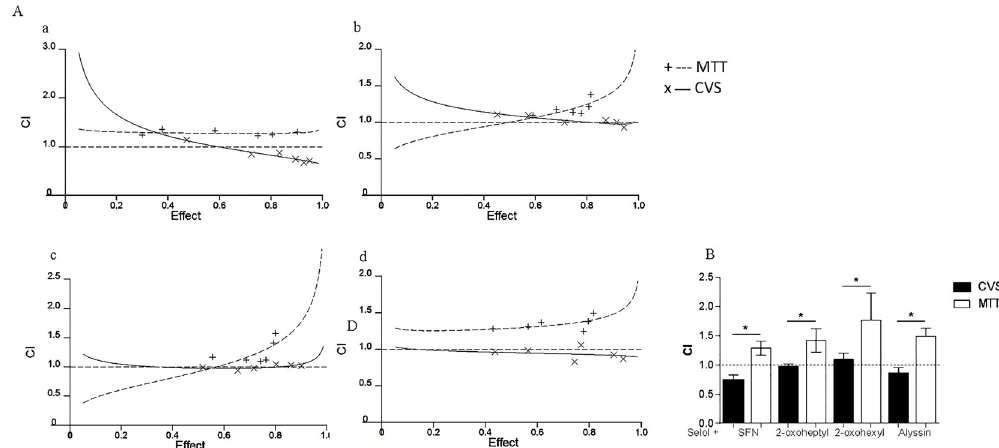
Fig 1. (A) Effect of the test method on the drug-drug interaction results. (a) Selol and SFN, (b) Selol and 2-oxoheptyl ITC, (c) Selol and 2-oxohexyl ITC, (d) Selol and alyssin. Combination index (CI) plots present CI as a function of effect (fa = fraction affected, defined as percentage inhibition/100) from 0.05 to 0.95 (5 – 95% cells killed). CI > 1.0 indicates antagonism, CI = 1 indicates additive effects, and CI < 1.0 indicates synergism. x, experimental data obtained with MTT assay. +, experimental data obtained with CVDE assay. Dashed (for MTT) and solid (for CVS) lines = computer simulation for Fa-CI plot. (B) Discrepancies between CI calculated on the basis of data obtained with MTT and CVS assays at fa 0.9. CI > 1.0 indicates antagonism, CI = 1 indicates additive effects, and CI < 1.0 indicates synergism. * significant difference, p <